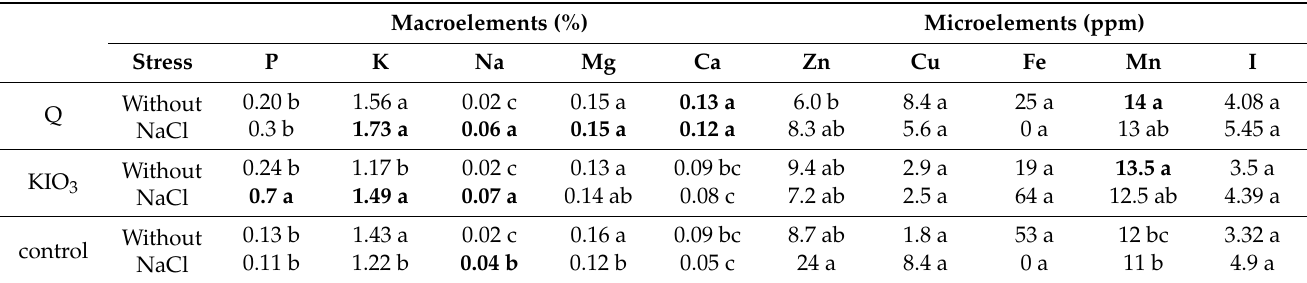
Table 6. Effect of iodine- based products on minerals content in fruits with and without salt stress.